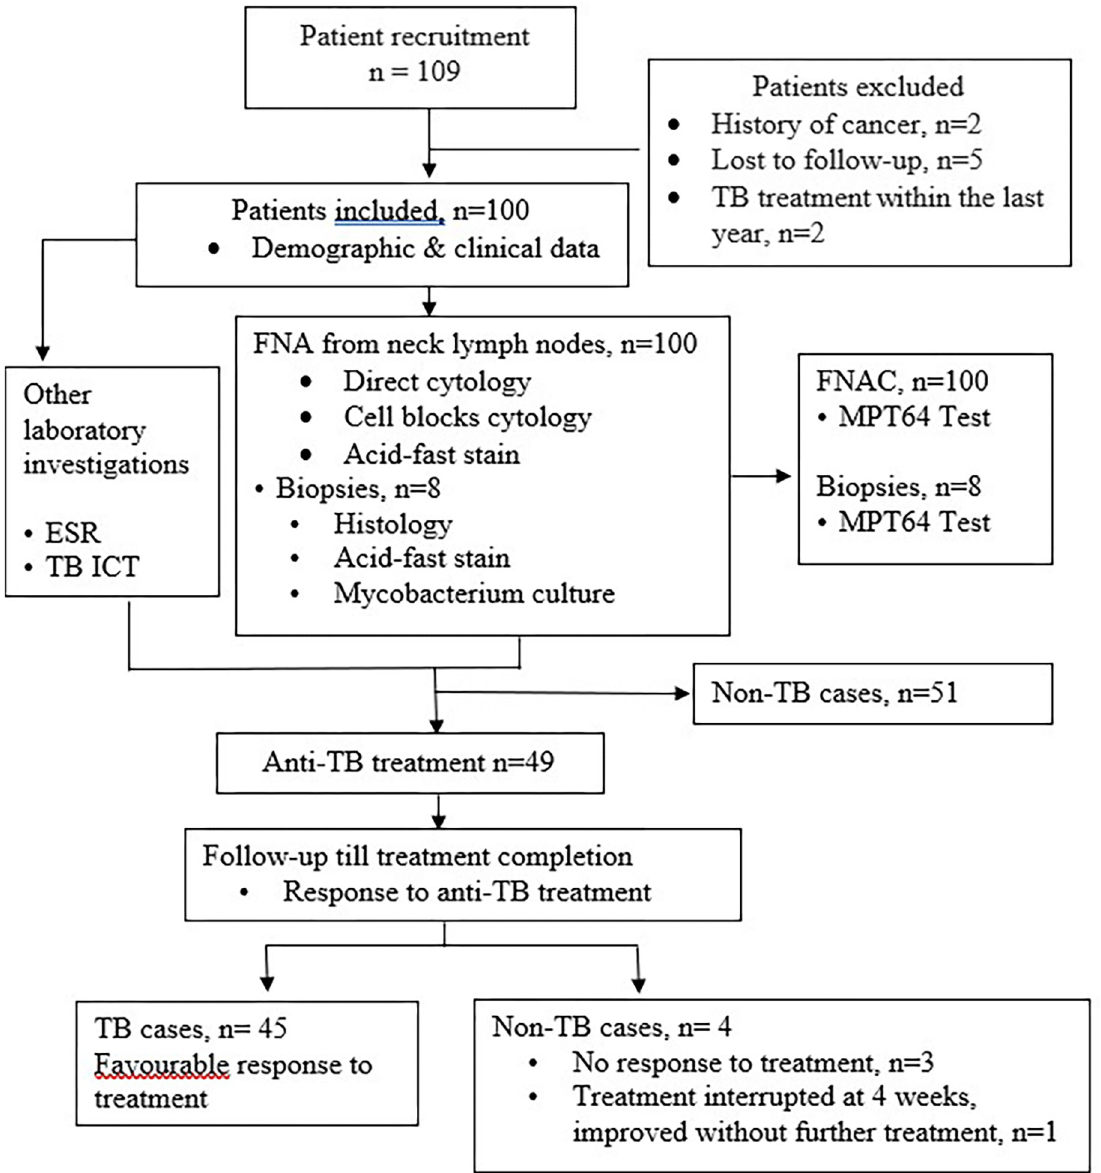
Fig 1. Study design, follow-up, and patient categorization into TB and non-TB cases. Abbreviations: EPTB, extrapulmonary tuberculosis; TB, tuberculosis; ESR, erythrocyte sedimentation rate; FNA, fine-needle aspirates; TB ICT, immunochromatographic test for tuberculosis; AFB, acid-fast